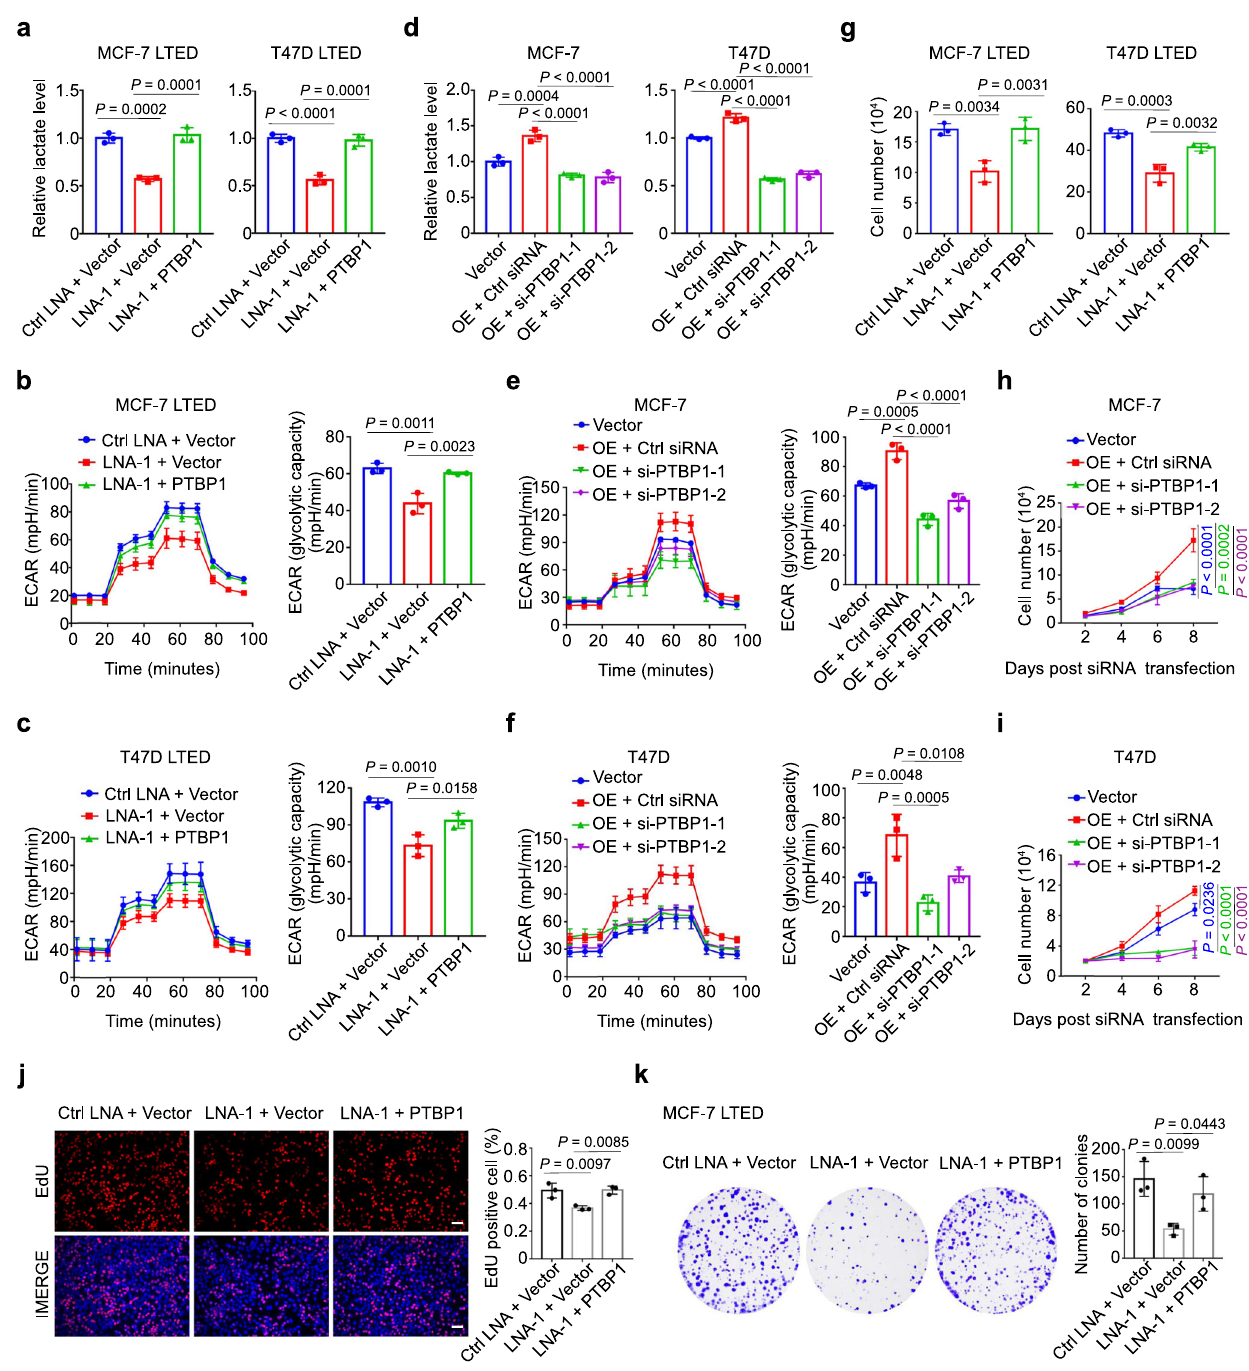
Fig.4|DIO3OSregulatesLTEDcellproliferationandglycolysisthroughPTBP1. a Lactate production of MCF-7/T47D LTED cells co-transfected with control LNA/ DIO3OS-targeting LNA and control vector/PTBP1 overexpression plasmid. b , c ECAR values and calculated glycolytic capacity of MCF-7 LTED ( b ) and T47D LTED( c )cellswiththeindicatedtreatments. d LactateproductionofparentalMCF- 7/T47D cells transfected with control construct or co-transfected with